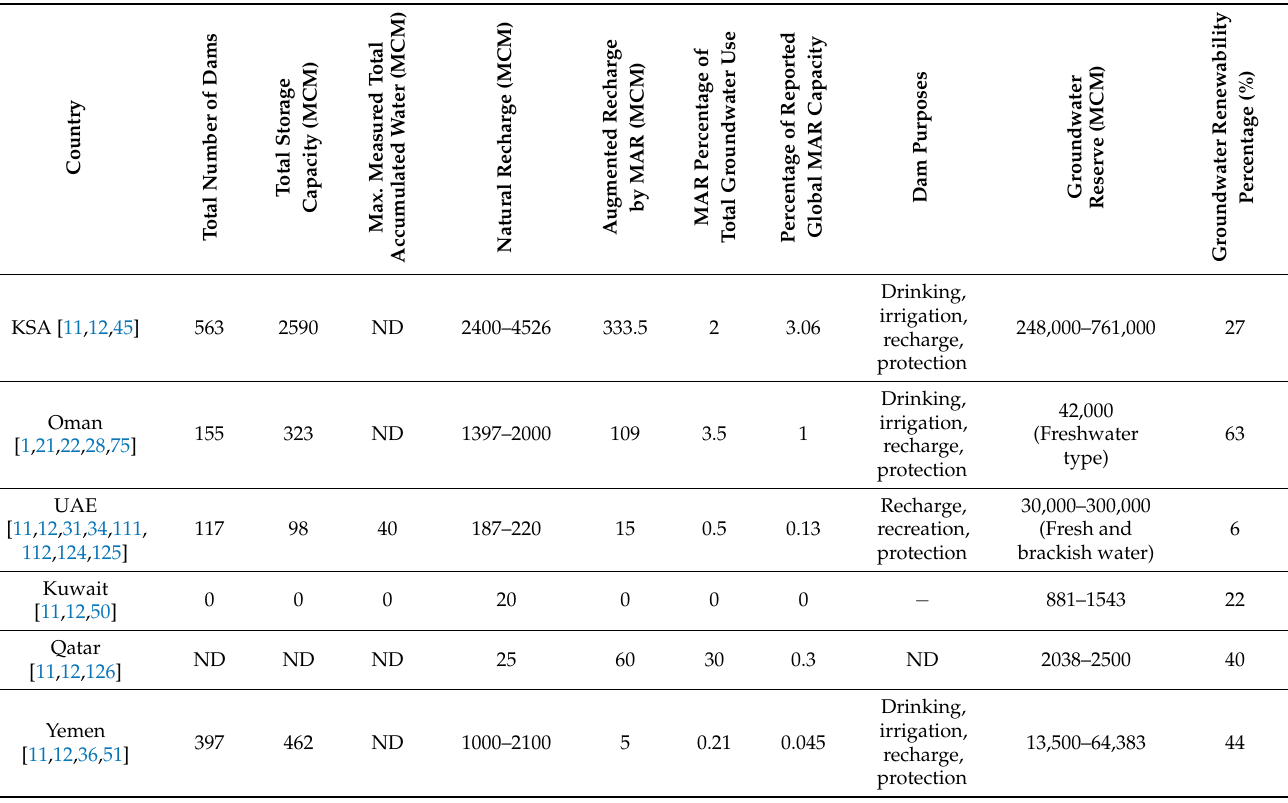
Table 3. Number of dams, storage capacity, MAR volume, and groundwater renewability percentage in the MENA